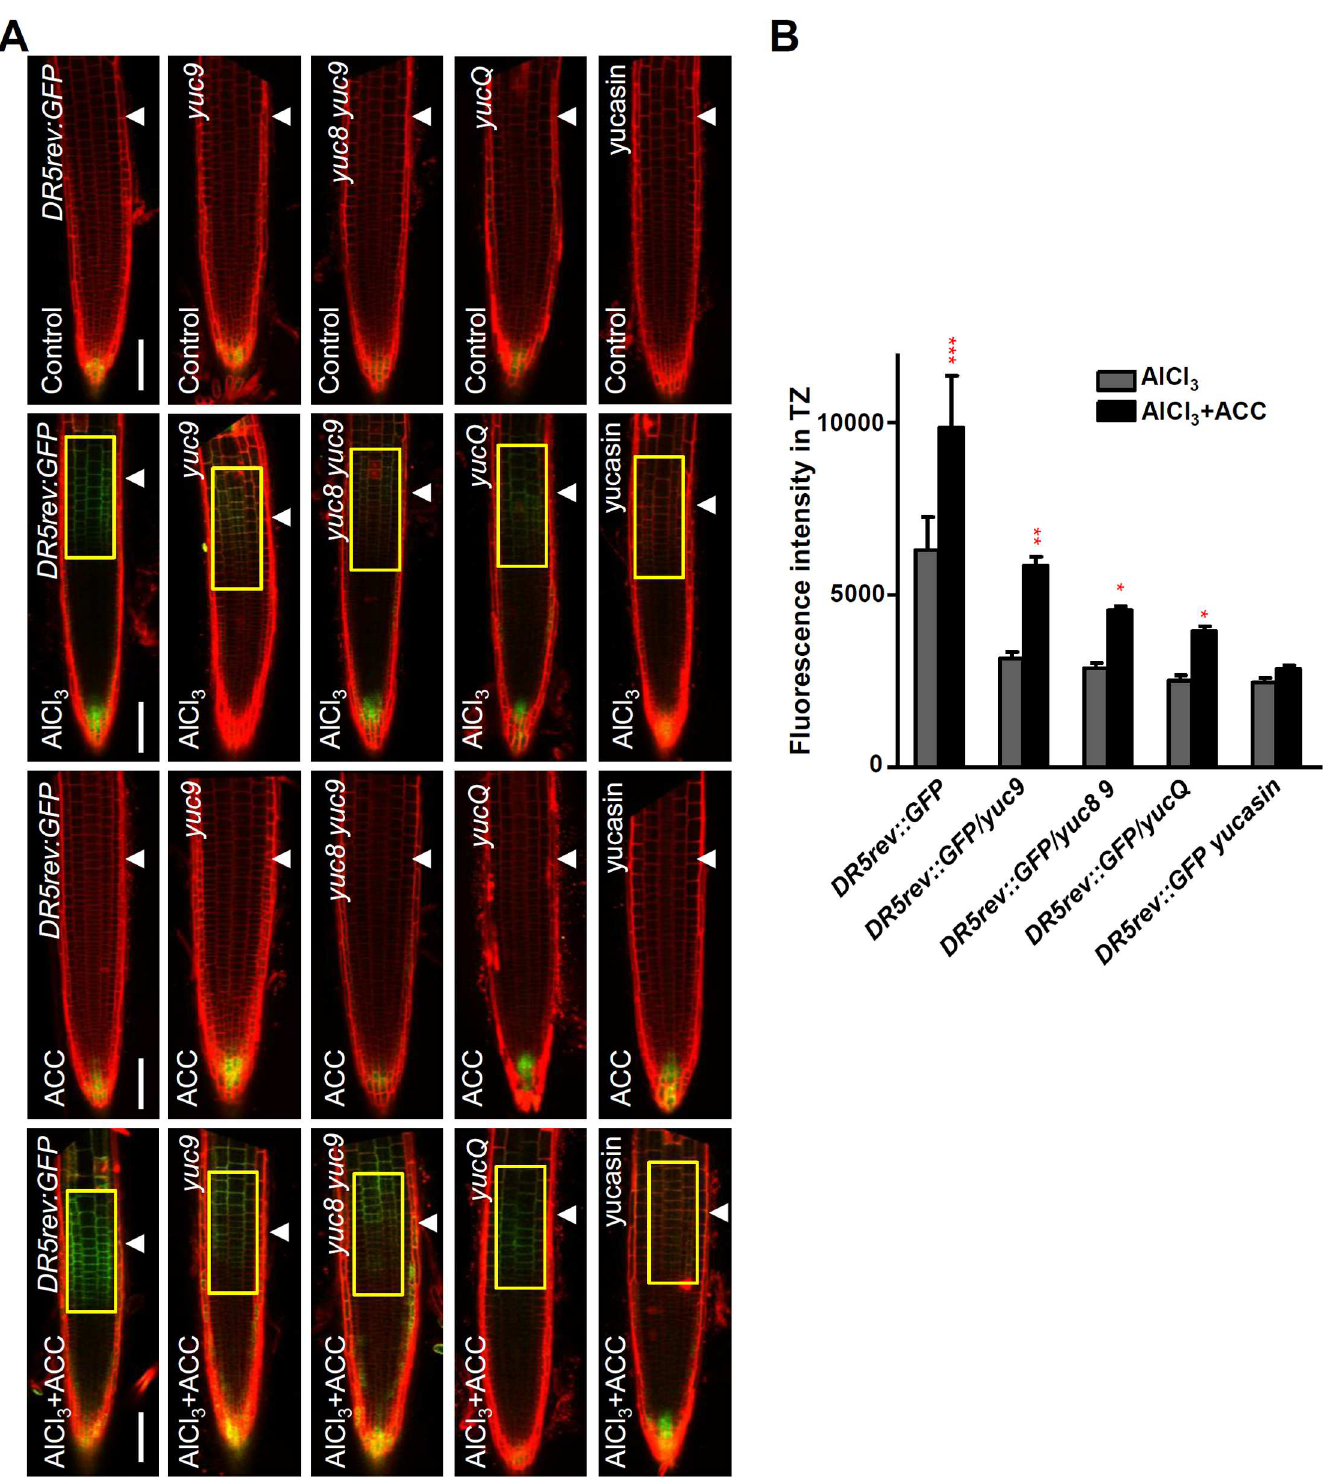
Fig 6. YUCs-dependent auxin biosynthesis contributes to ethylene enhanced local auxin signaling in root-apex TZ under Al stress. (A) The expressionof DR5rev : GFP , DR5rev : GFP/yuc9 , DR5rev : GFP/yuc8 yuc9 and DR5rev : GFP/yucQ transgenes, or of DR5rev : GFP after yucasin treatment, in the epidermis of the root-apex in the presence of Al and/or ACC. Single treatments are performed on five-day old seedlingswith 25 μ M AlCl 3 for 2 hours or on three-day old seedlingswith 1 μ M ACC or 10 μ M yucasin for 2 hours. Co-treatments were done on three-day old transgenicseedlings(30 seedlings